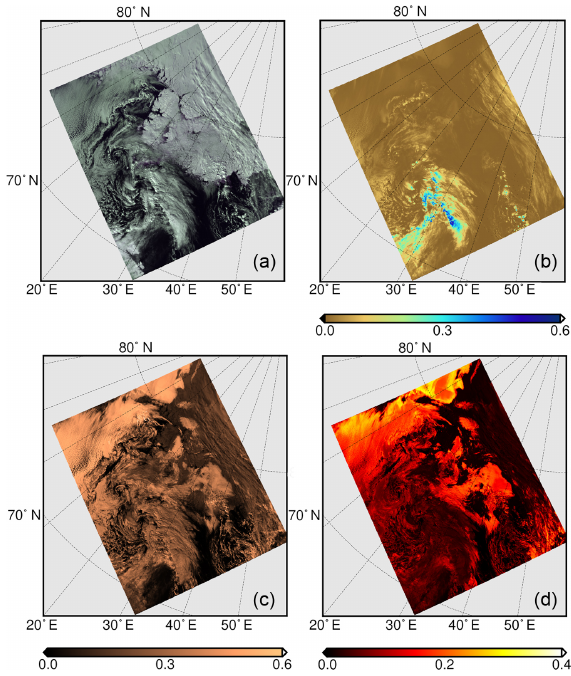
Figure 2. (a) The RGB false-colour image (using 0.67, 0.87 and 0.55µm channels) of SLSTR over Svalbard, 18 April 2017, (b) 1.37µm reflectance, (c) 1.6µm reflectance, (d) 3.7µm re-